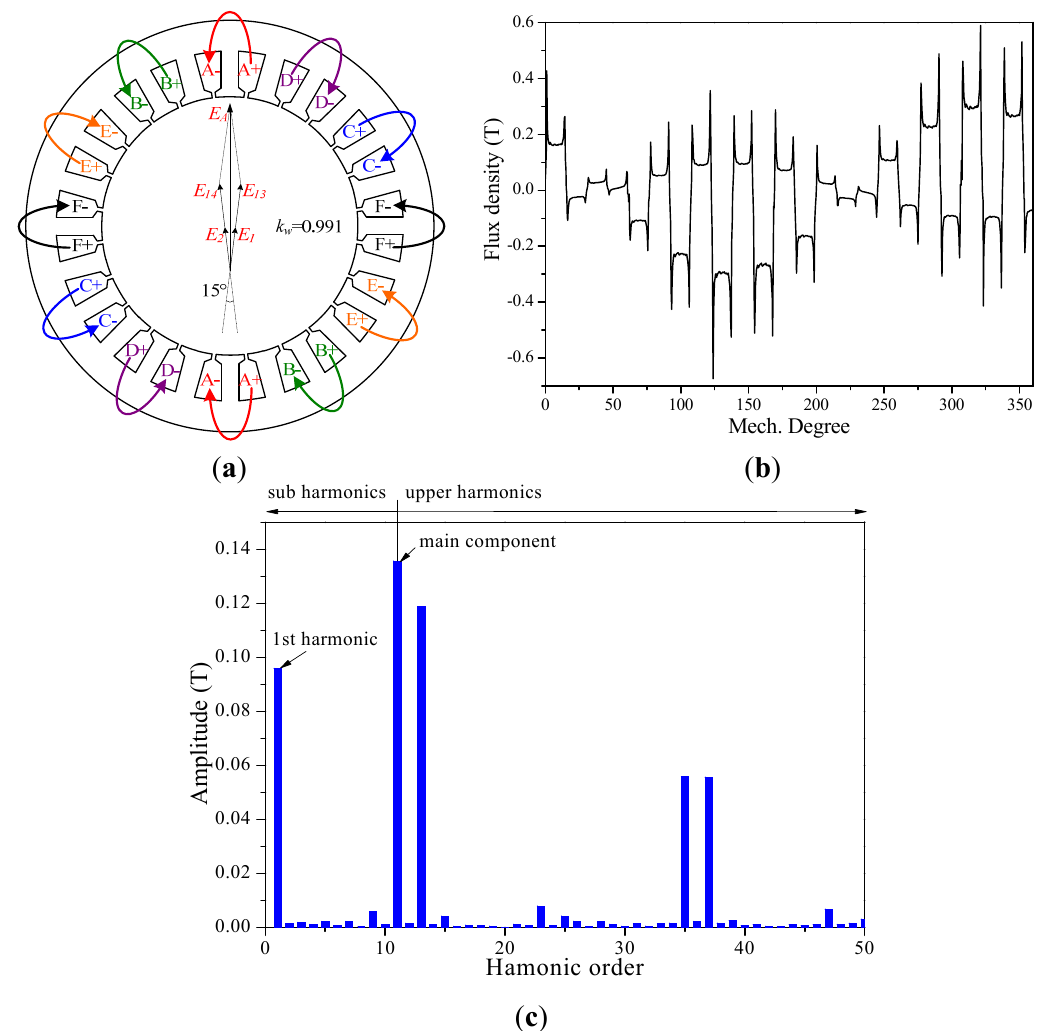
Figure 2. Winding arrangement and main magnetomotive force (MMF) harmonic analysis of the 24-slot alternate-teeth-wound asymmetric six-phase PMSM: ( a ) stator winding arrangement and synthesized electromotive force (EMF) vector; ( b ) air-gap flux density; and ( c ) winding-produced air-gap flux density